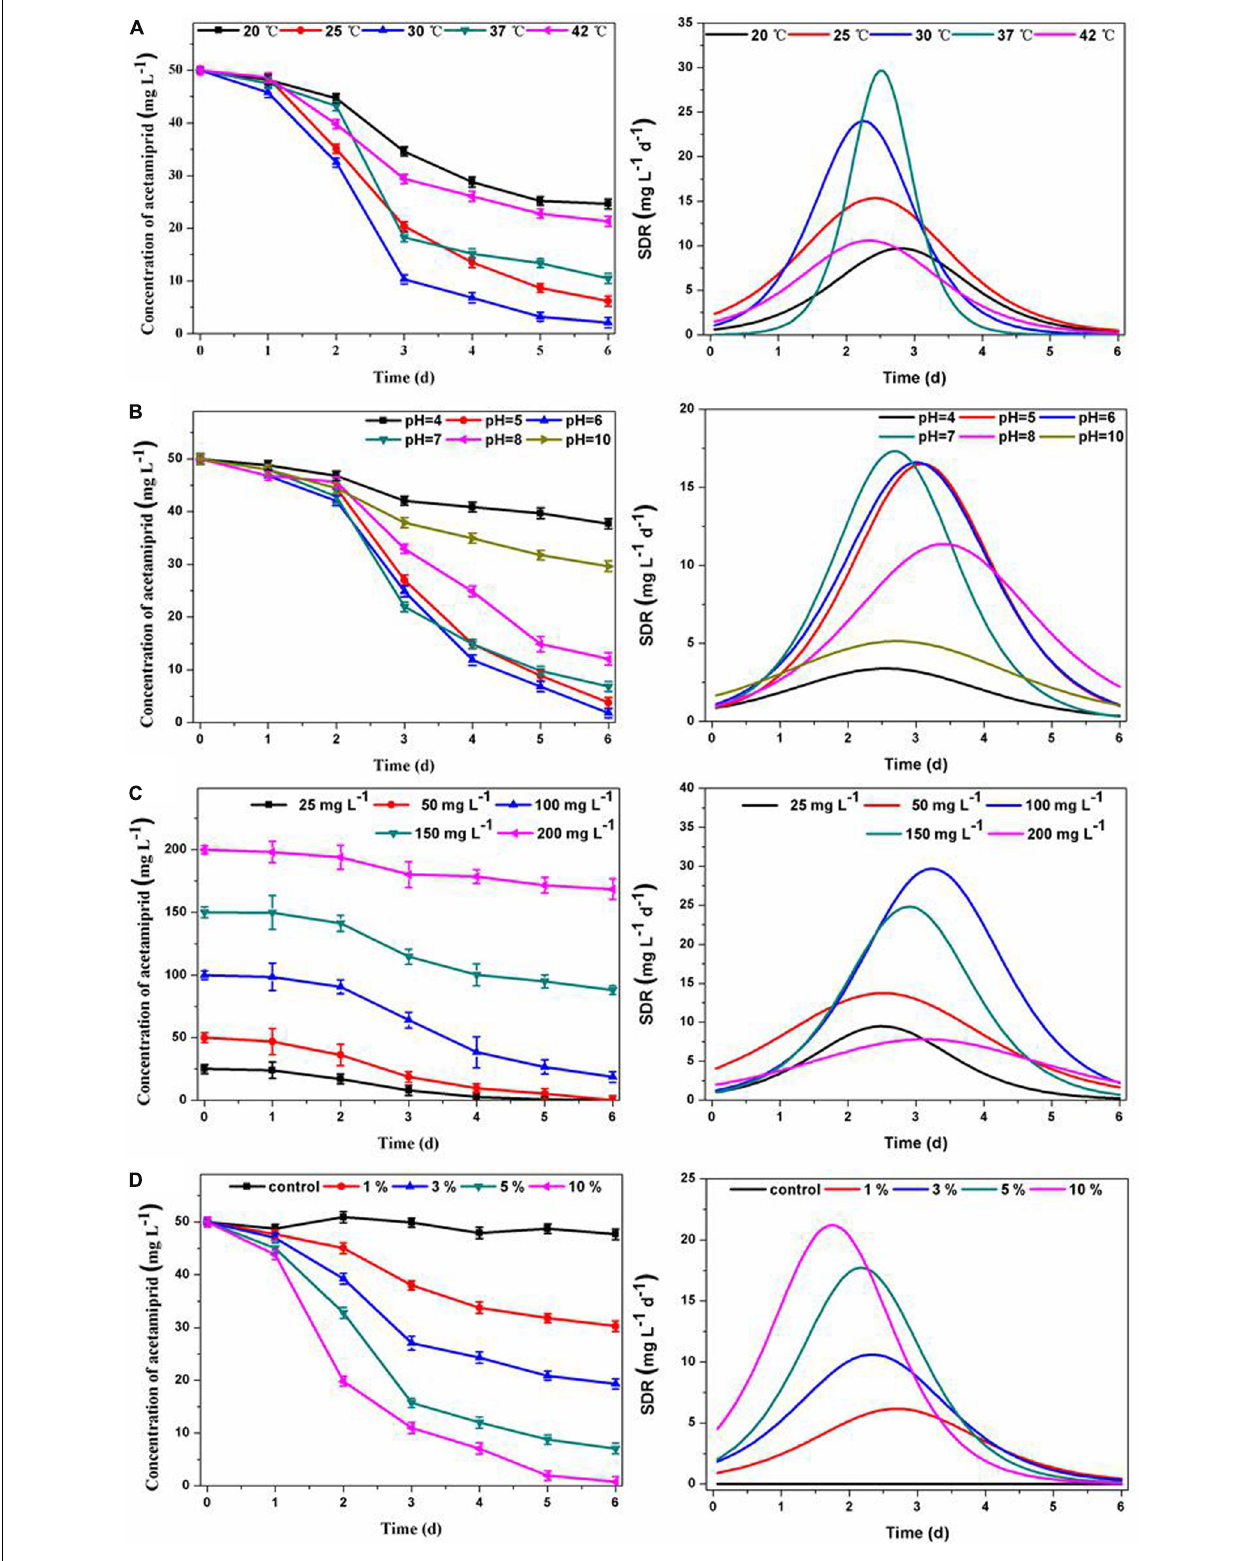
FIGURE 2 | Effects of physicochemical conditions on acetamiprid biodegradation by consortium ACE-3 and degradation kinetics curve of SDR with time-course. (A) Temperature; (B) pH; (C) acetamiprid concentration; (D) inoculum size. The data represent the means ± standard deviations of triplicate experiments.